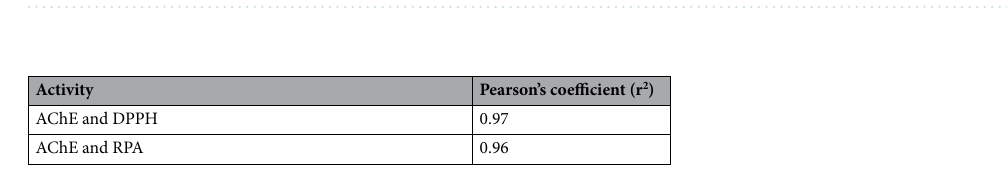
Table 2. Summary of lipinski and ADME analysis. BBB blood brain barrier, CYP cytochome P, HIA human intestinal absorption, HBD hydrogen bond donor, HBA hydrogen bond acceptor, MR molecular refractivity, MW molecular weight.